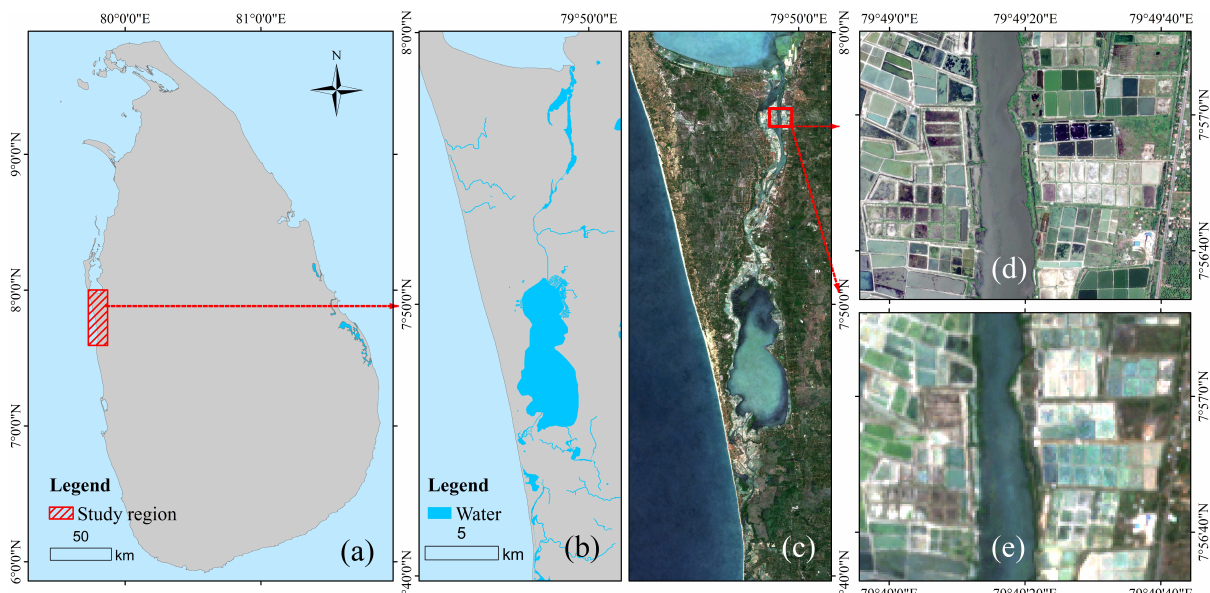
Figure 2. Study region selected in this study: ( a ) location of the study region; ( b ) overview of the study region; ( c ) Sentinel-2 true-color RSI; ( d ) detailed image from 0.5 m Hr-RSI, where SOAPs can be explicitly seen; ( e ) detailed image from 10 m Sentinel-2 Mr-RSI, where SOAPs are hard to distinguish. All maps in this paper are projected using the Cylindrical Equal Area project (ESRI: